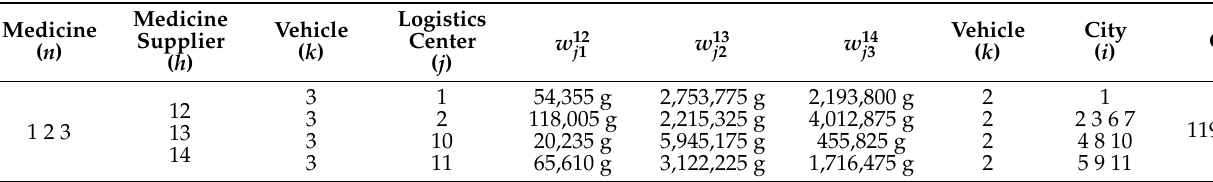
Table 4. Optimal solution for medicine logistics.